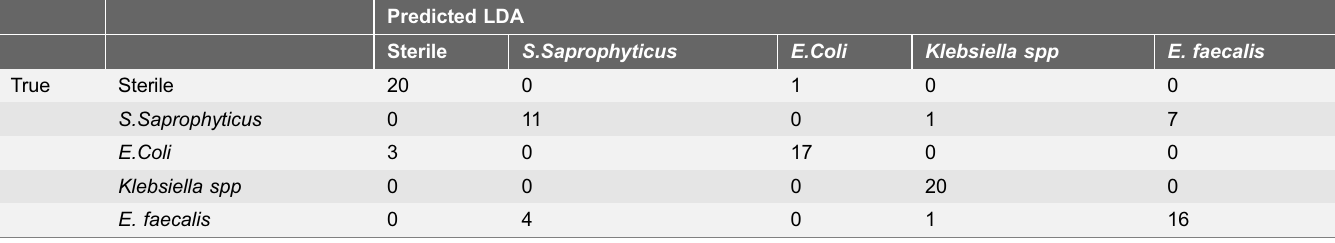
Table 3. Identification of bacterial species and sterile